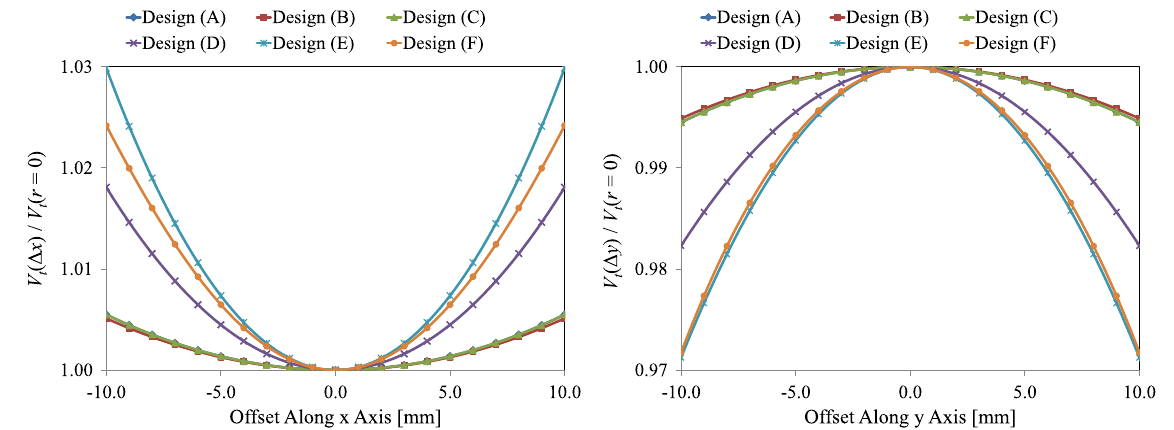
FIG. 28. Normalized transverse deflecting voltage in horizontal (offset along x axis) and vertical (offset along y axis) directions for designs shown in Fig. 8 [Designs (A) and (C) are identical].